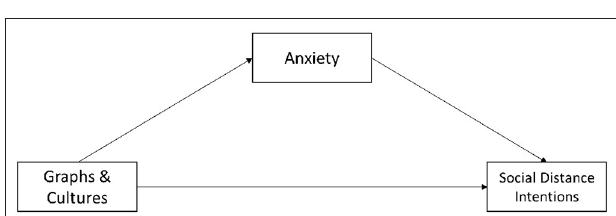
risk and return to normal, maintaining group harmony (41).